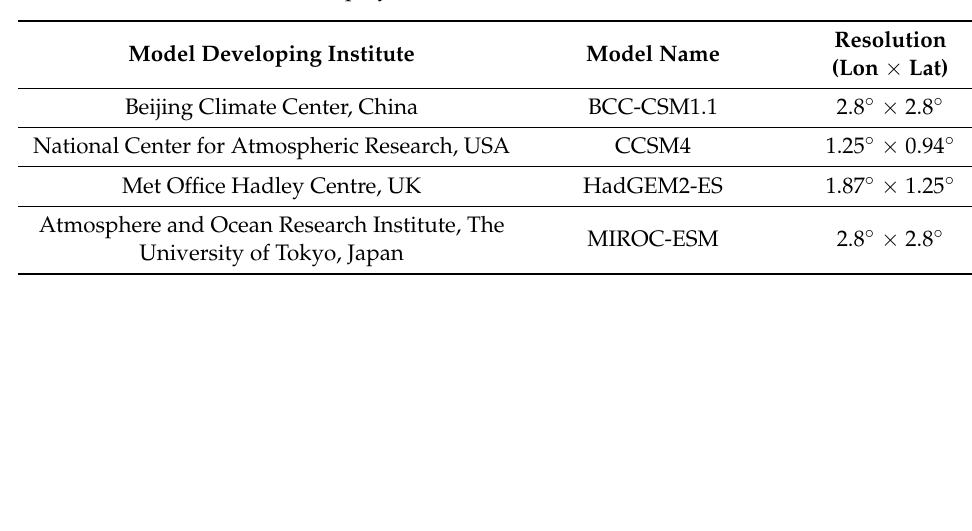
Table 1. List of CMIP5 GCMs employed in this research.